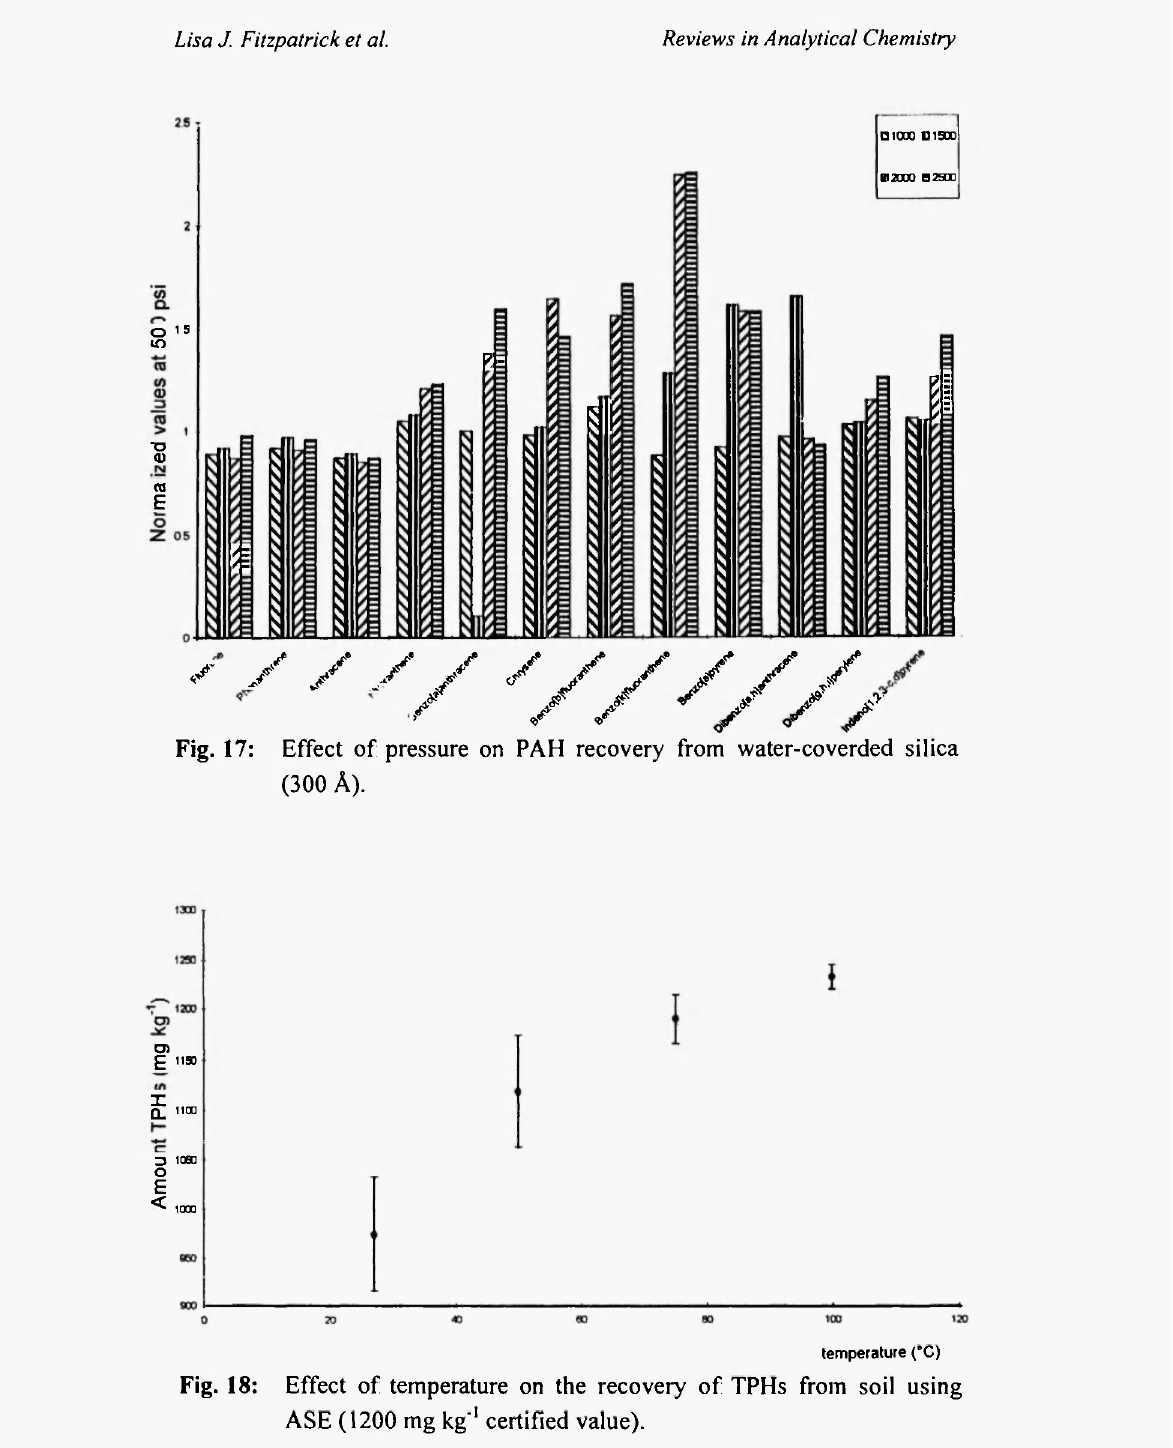
Fig. 18: Effect of temperature on the recovery of TPHs from soil using ASE (1200 mg kg" 1 certified